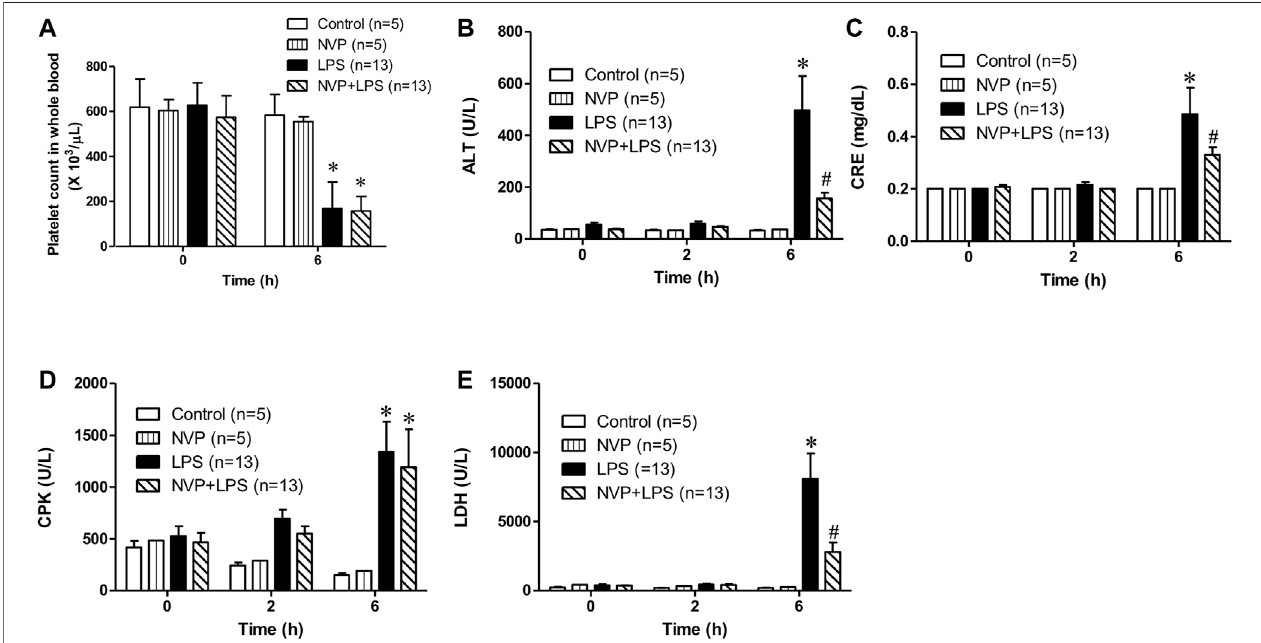
FIGURE2| EffectsofNVP-AUY922onorgandamagemarkers. (A) Plateletcount.EffectsofNVP-AUY922pre-treatmentonplateletcountinwholeblood6 hafter rats being subjectedto LPSadministration. (B) Liverfunction test. EffectsofNVP-AUY922on plasmalevels ofalanine aminotransferase. ALT: alanine aminotransferase. (C) Renal function test. Effects of NVP-AUY922 on plasma levels of creatinine. CRE: creatinine. (D) Skeletal muscle injury. Effects of NVP-AUY922 on plasma levels of creatine phosphokinase. CPK: creatine phosphokinase. (E) Cytotoxicity. Effects of NVP-AUY922 on plasma levels of lactate dehydrogenase. LDH: lactate dehydrogenase. NVP: NVP-AUY922 5 mg/kg. Values are expressed as mean ± SEM. * p < 0.05 vs. Control group, # p < 0.05 vs. LPS group.